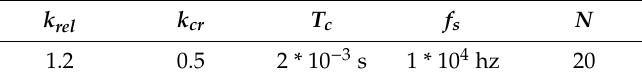
Table 2. The main parameters for local